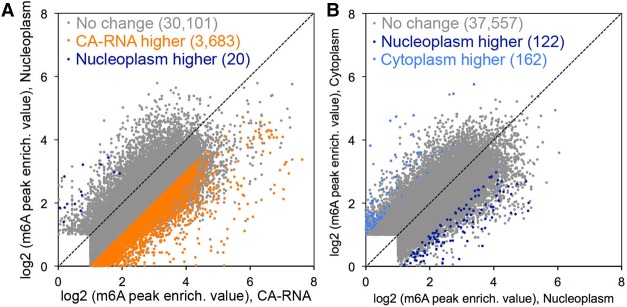
Each individual m6A modification is modified mostly with the same level for each of the three cell fractions. (A) Comparison of individual m6A peak signal strength in CA-RNA and nucleoplasmic RNA for the same m6A peaks (each dot is an individual m6A peak: no changes in gray, CA-RNA higher in orange, and nucleoplasm higher in dark blue). FDR <5%, Fisher's exact test. To determine m6A peaks that are higher in CA-RNA, for each m6A peak region, we enumerated reads of m6A immunoprecipitation and the input for CA-RNA and Nucleoplasm RNA, evaluating statistical significance with Fisher's exact test, using stringent FDR cutoffs to correct for multiple hypothesis testing. The determination that an m6A peak region was higher in CA-RNA required (1) the reads of mRNAs in m6A peak regions to be adequate for m6A peak region detection in both CA-RNA and nucleoplasmic mRNA (reads per kilobase per million mapped reads [RPKM] ≥1) and (2) FDR ≤0.05 and a twofold or higher of peak region enrichment in CA-RNA compared with nucleoplasmic mRNA. At a lower cutoff (e.g., ≥1.5-fold), the same conclusion held: that most m6A peaks are modified with the same level between CA-RNA and nucleoplasmic mRNA. (B) Comparison of individual m6A peak signal strength in nucleoplasmic RNA to cytoplasmic RNA for the same m6A peak. The same statistic criteria were used as in A. (Gray) No changes; (dark blue) nucleoplasm higher; (light blue) cytoplasm higher. FDR < 5%, Fisher's exact test. At a lower cutoff (e.g., ≥1.5-fold), again, the same conclusion held that most m6A peaks were modified at the same level in nucleoplasmic mRNA and cytoplasmic mRNA.